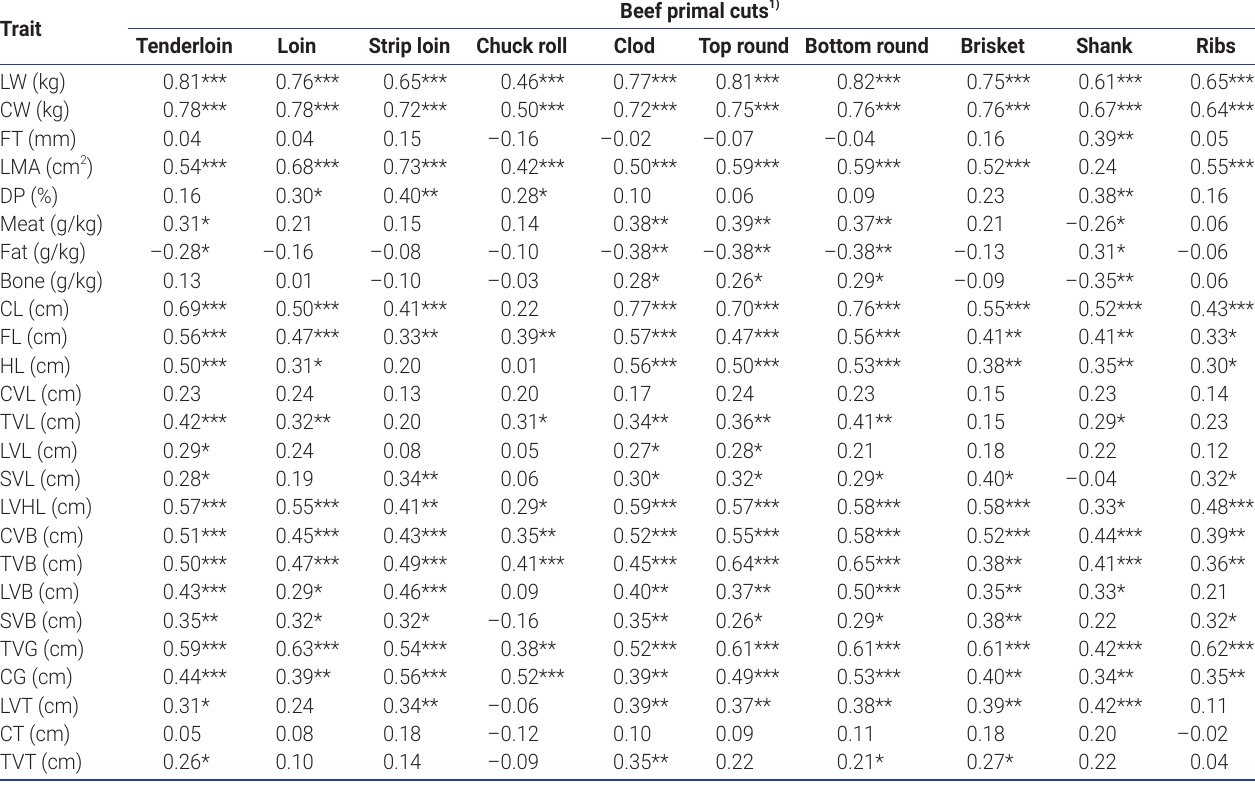
Table 3. Simple correlation coefficients between carcass grades, carcass weight, fat thickness, carcass size and yield of primal product